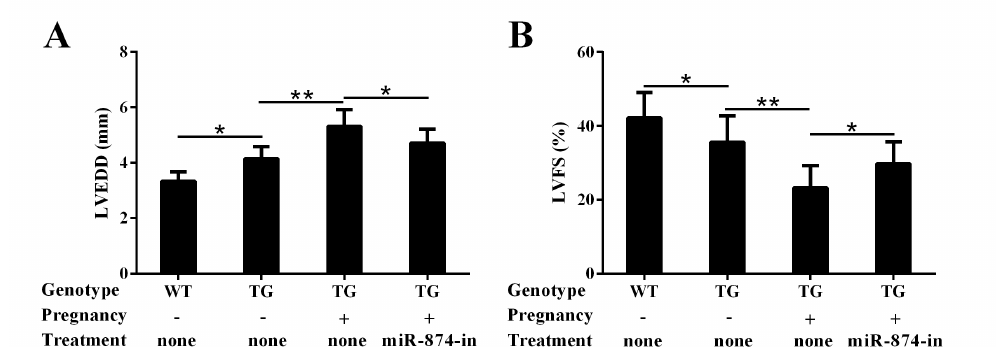
Figure 2. Echocardiographic analysis of left ventricular function. LVEDD (A) and LVFS (B) in survived mice from each group. Age- matched, female non-pregnant wild-type (WT, n=24) and Gαq transgenic mice (GT, n=24), pregnant Gαq transgenic mice (n=14) and